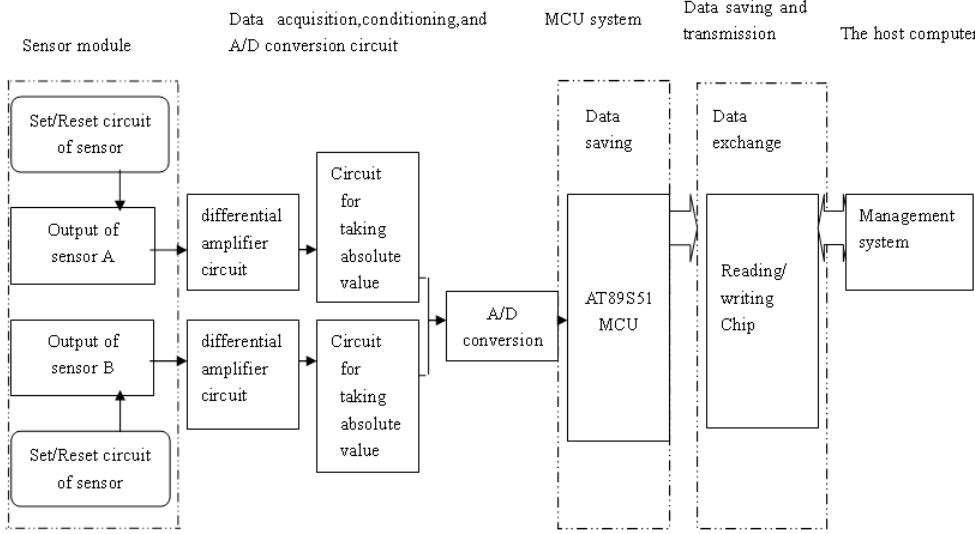
Figure 6. Hardware structure of the horizontal drilling-length detection system.